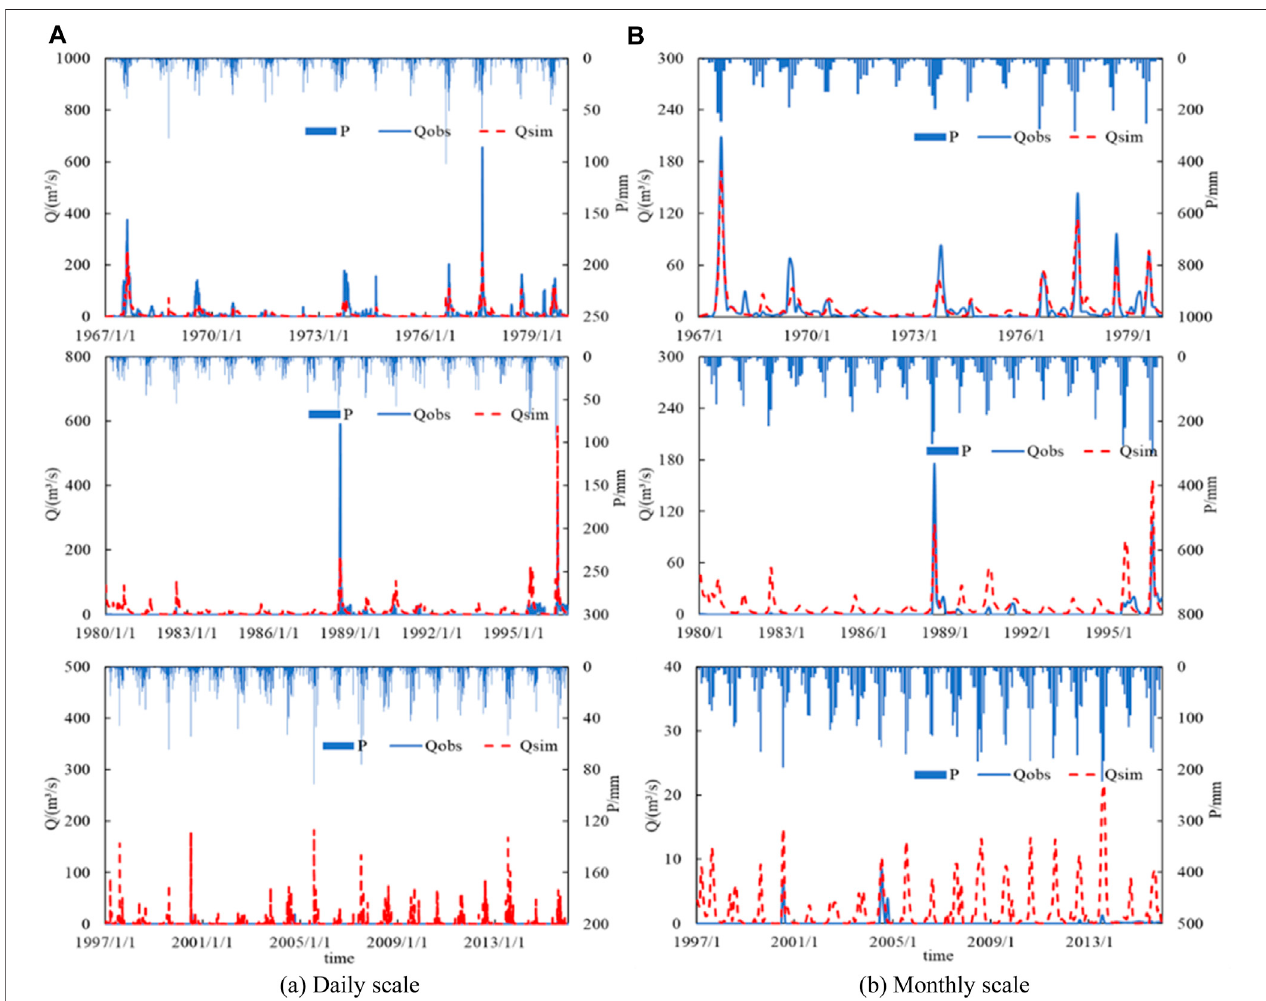
FIGURE 9 | Daily (A) and monthly (B) simulated and observed discharge (m³/s) during the three periods in the Zhulong River catchment.